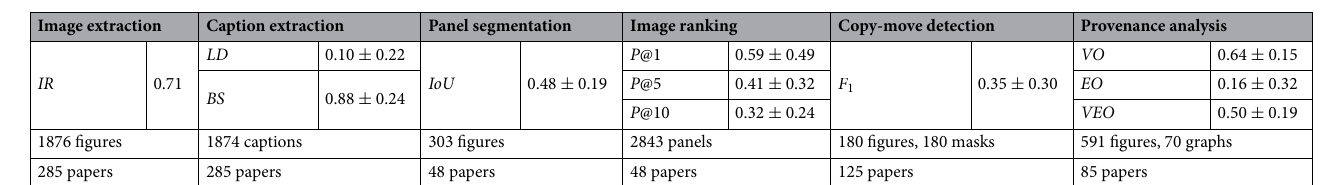
Table 1. Quantitative results of the tasks performed by SILA. All values belong to the real interval [0..1]. For all metrics but LD , the larger the value, the better the solution. All values are averaged over the sets of elements in the bottom row (± deviations), except for IR . Metrics: IR —image recall, LD —Levenshtein distance, BS — BertScore, IoU —intersection over union, P @ N —precision at top- N images, F 1 — F 1 -score, VO —vertex overlap, EO —edge overlap, VEO —vertex and edge